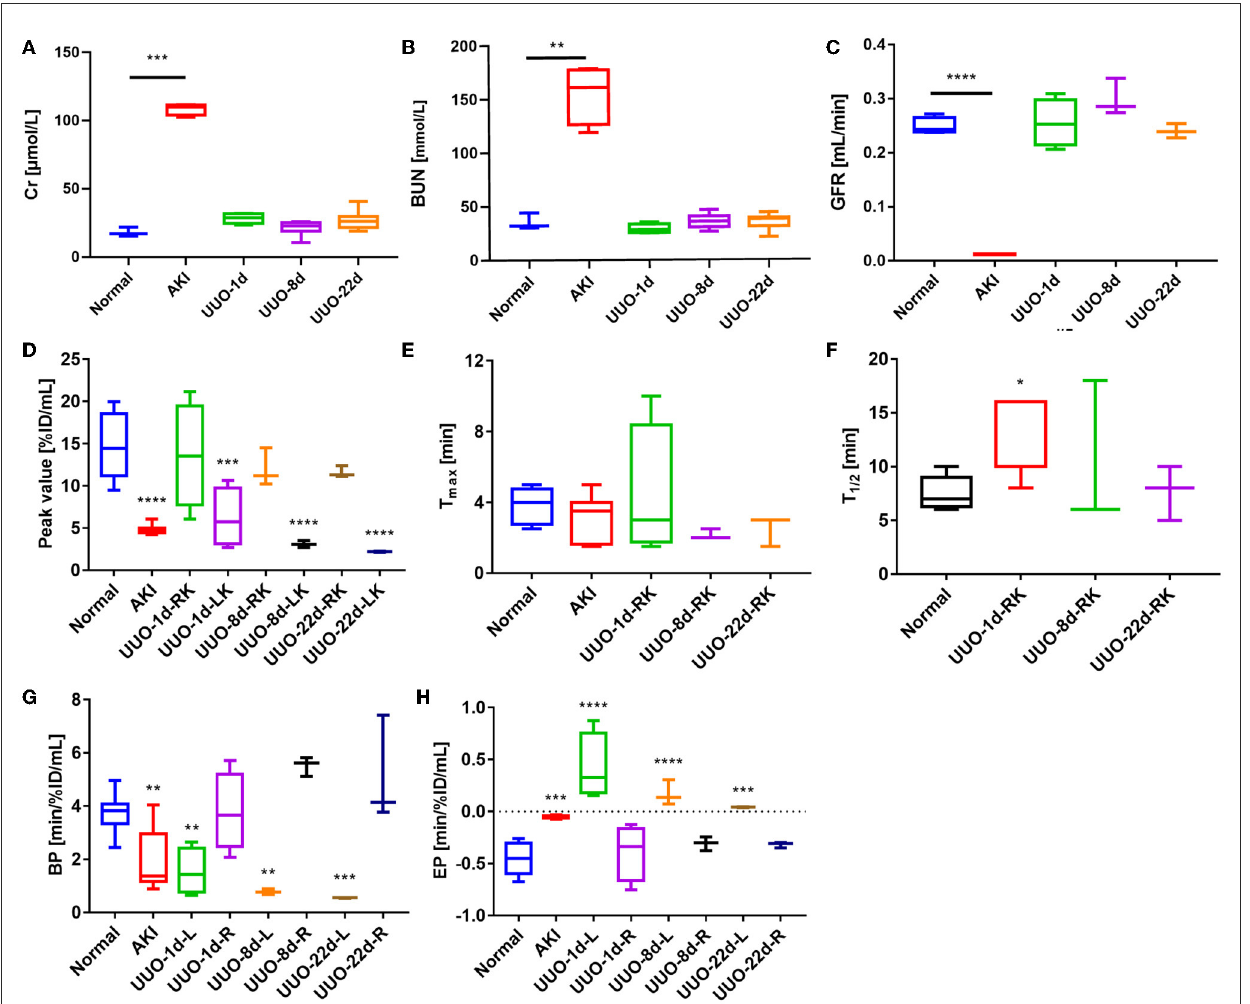
FIGURE4 Renal function of healthy mice and mice with renal dysfunction, as represented by glomerular filtration rate (GFR), creatinine (Cr), urea nitrogen (BUN), and other figure parameters. (A) The Cr values of healthy mice and mice with renal dysfunction. (B) BUN values of healthy mice and mice with renal dysfunction. (C) The GFR values of healthy mice and mice with renal dysfunction. (D) The renogram peak value of healthy mice, AKI mice, and the split kidneys in UUO mice. *The peak value of the obstructed kidney (left kidney) in UUO mice was 4min p.i. (E) The renogram T max value of healthy mice, AKI mice, and the right kidney in UUO mice. (F) The renogram T 1 / 2 value of healthy mice, AKI mice, and the right kidney in UUO mice. (G) The renogram BP of healthy mice, AKI mice, and the split kidneys in UUO mice. (H) The renogram EP of healthy mice, AKI mice, and the split kidneys in UUO mice. * p < 0.05, ** p < 0.01, *** p < 0.001, **** p <